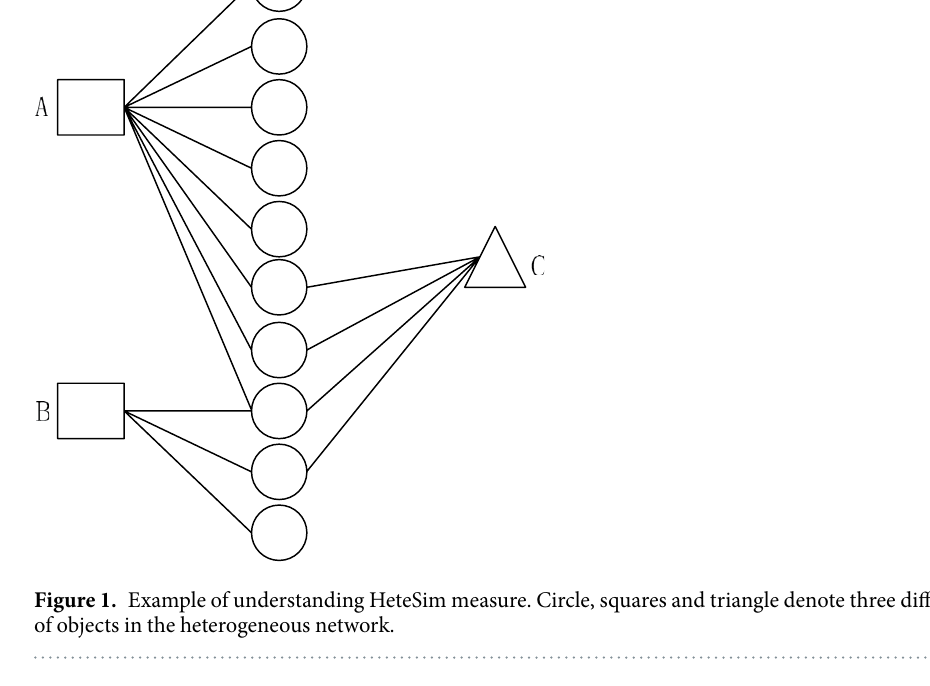
most commonly used approach is guilt-by-association (GBA) 19 , which provides the central top-down principle for analyzing gene networks in functional terms or assessing their quality in encoding functional information. New emerged methods, including the Katz method 20 , Combining dATa Across species using Positive-Unlabeled Learning Techniques(CATAPULT) 19 , Random Walk with Restart (RWR) 21 , and LncRNA-protein Interaction prediction based on Heterogeneous Network model (LPIHN) 22 , have extended the association from just direct protein interactions to more distant connections in various ways. The KATZ measure 20 is a weighted sum of the number of paths in the network that measures the similarity of two nodes. CATAPULT 19 is a supervised machine learning method that uses a biased support vector machine where the features are derived from walks in a heter- ogeneous gene-trait network. RWR 21 is a method for prioritization of candidate genes by use of a global network distance measure, random walk analysis, for definition of similarities in protein-protein interaction networks and it add weight to the assumption that phenotypically similar diseases are associated with disturbances of sub- networks within the larger protein interactome that extend beyond the disease proteins themselves. LPIHN 22 is a network-based method by implement a random walk on a heterogeneous network. PRINCE is a global method based on formulating constraints on the prioritization function that relate to its smoothness over the network and usage of prior information. Compared with LPIHN and RWR, PRINCE propagates information in a smaller network but contains more connotative meaning when build the initial probability values and has made great performance in gene prioritization 23 and disease identification 24 .